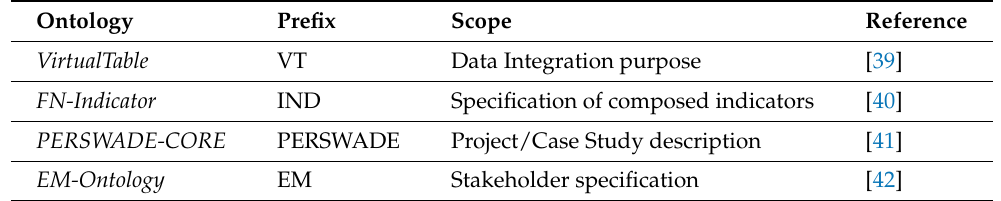
Table 1. Linked external